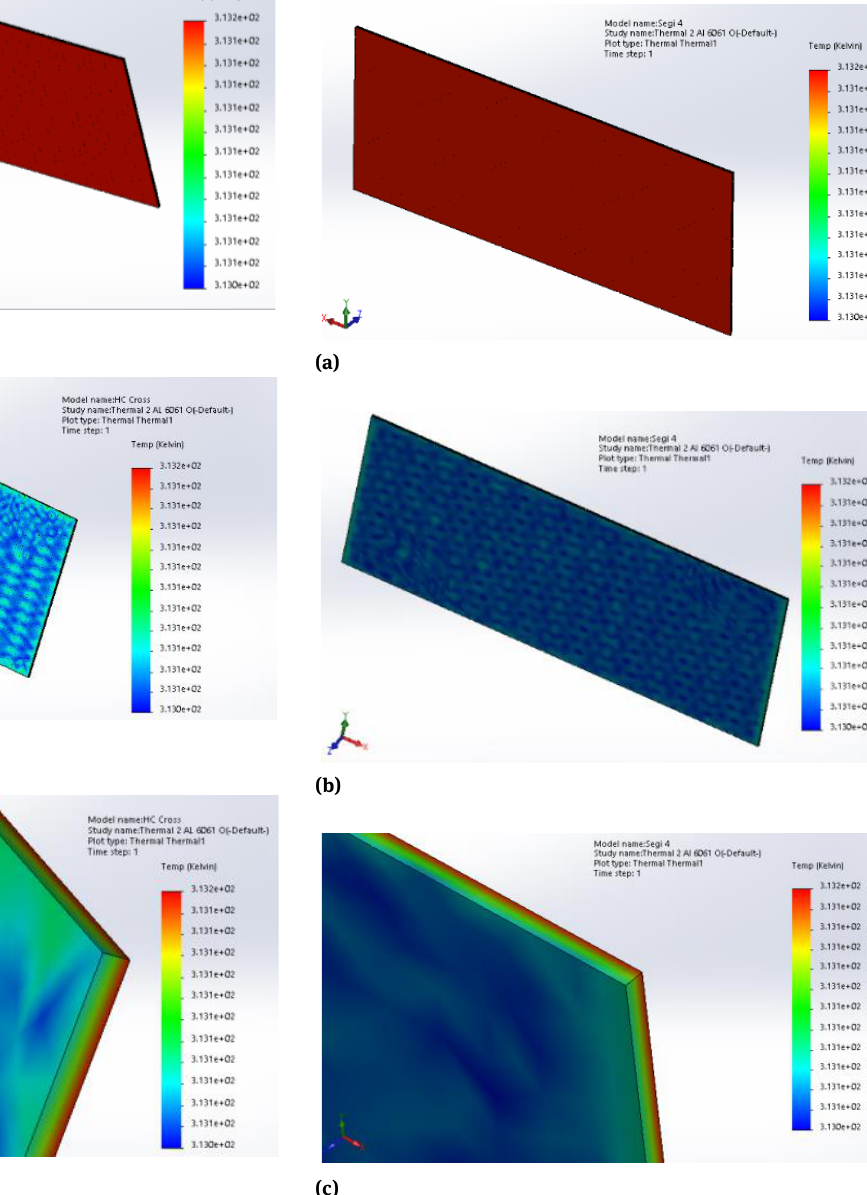
Figure 20: Result of the thermal simulation for the cross honey- comb: (a) outer surface, (b) inner surface, (c) edge